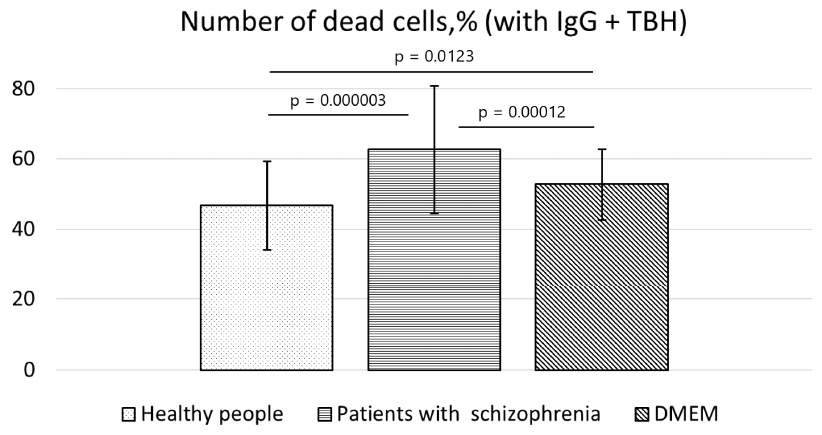
Figure 5. Percentages of dead SH-SY5Y cells after 24 h of induced oxidative stress (TBH) combined with incubation with IgG from schizophrenia patients or from healthy individuals or without antibodies (the culture medium alone).